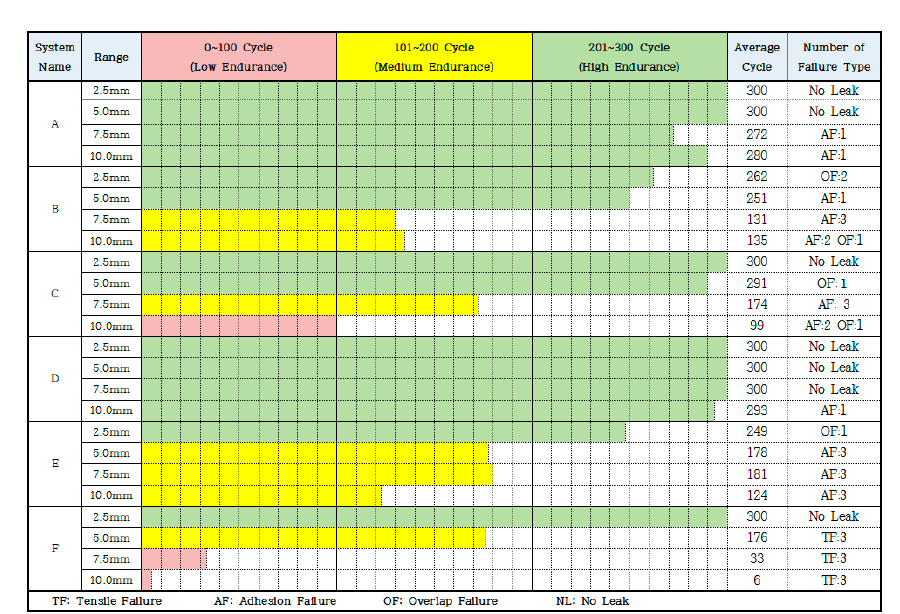
Figure 8. Endurance cycles of dry surface test specimens (Averaged).